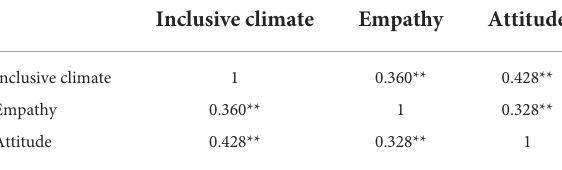
TABLE 4 Correlations among inclusive climate, empathy and attitude to peers with